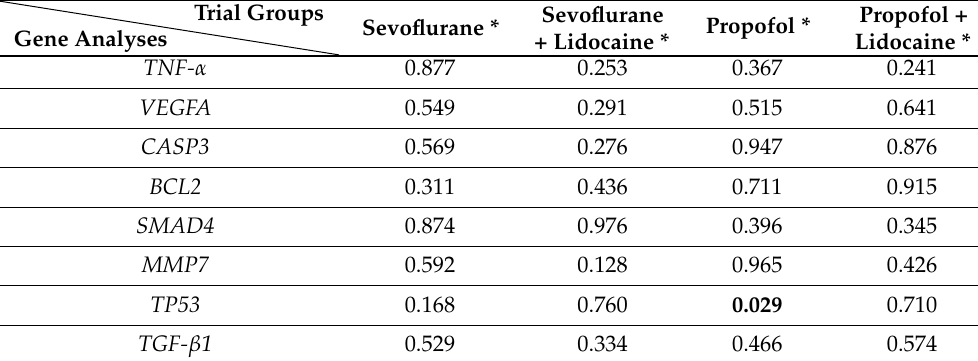
Table 2. A comparison of gene expressions in study groups, where * is the p -value when comparing T1 with